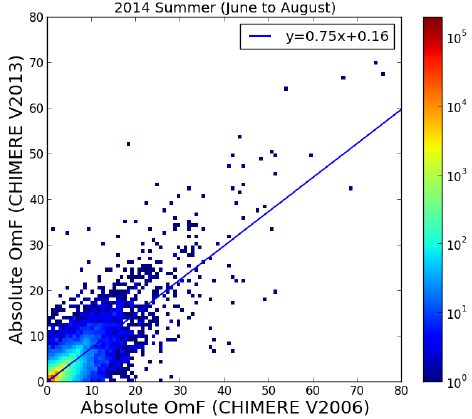
Figure 3. The comparison of the absolute OmF (10 15 moleculescm − 2 ) of CHIMERE v2006 and CHIMERE v2013 for the whole East Asian domain from June to August. The colorbar represents the frequency of satellite observations for that specific value of